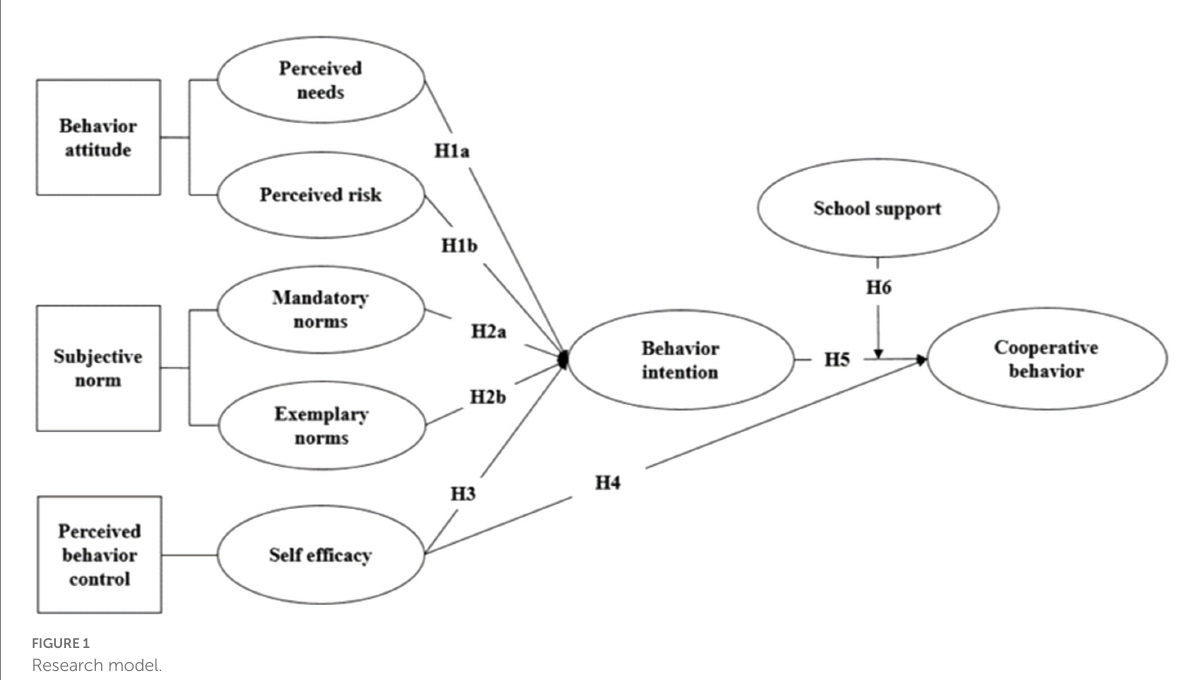
FIGURE 1 Research